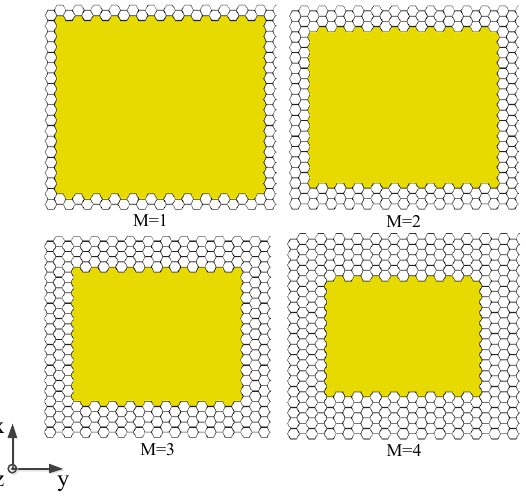
Figure 5. The hybrid model of honeycomb panel with different M values.